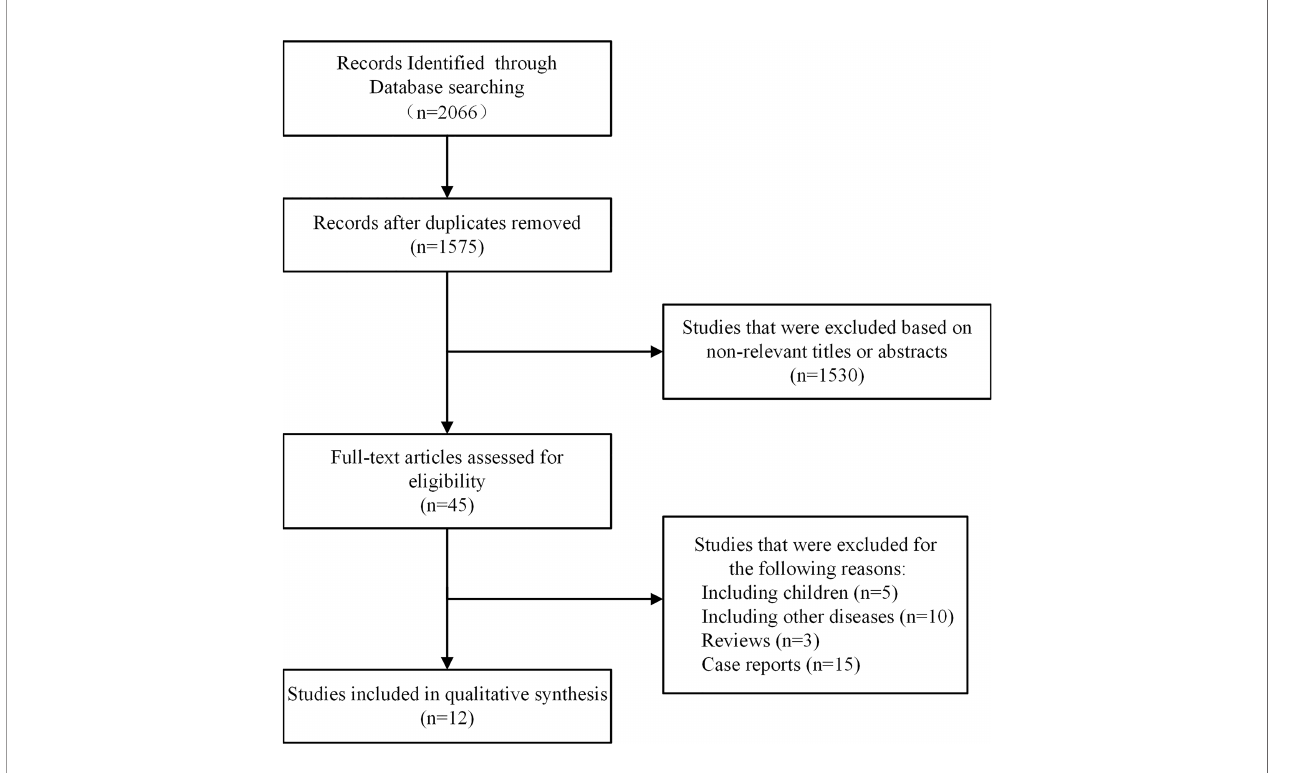
FIGURE 1 | Flowchart of the included